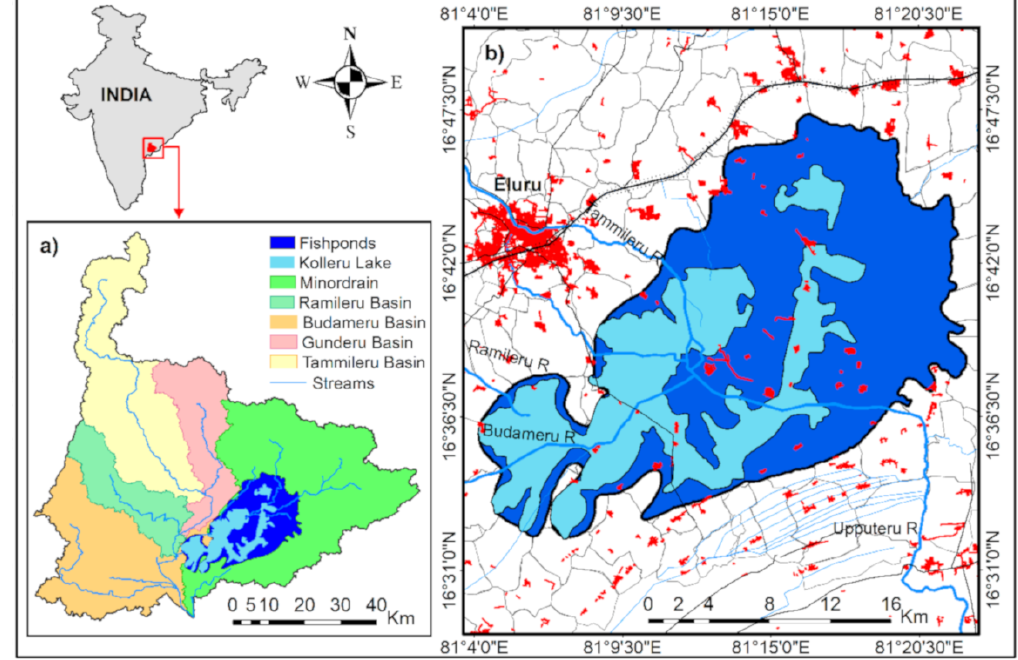
Figure 1. Location of the study site: ( a ) Kolleru Lake tributary river catchment; and ( b ) Kolleru Wildlife Sanctuary (in the dark blue background, i.e., fishponds occupied